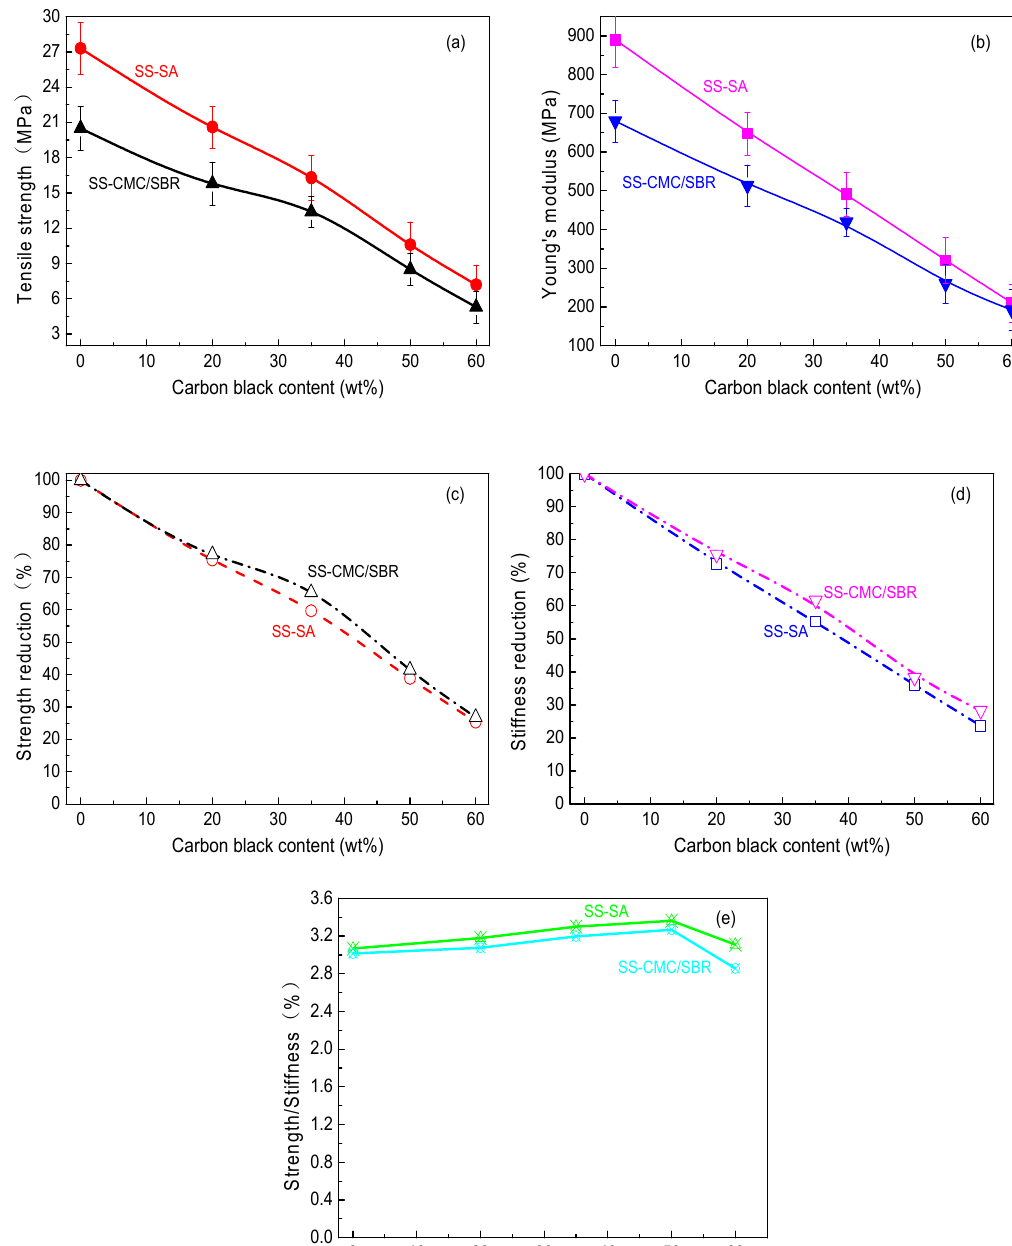
Figure 2. Evolution of ( a ) maximum stress; ( b ) Young ′ s modulus; ( c ) strength reduction; ( d ) stiffness reduction and ( e ) ratio of strength to stiffness of BCC films with SS content for different aqueous polymer matrices.